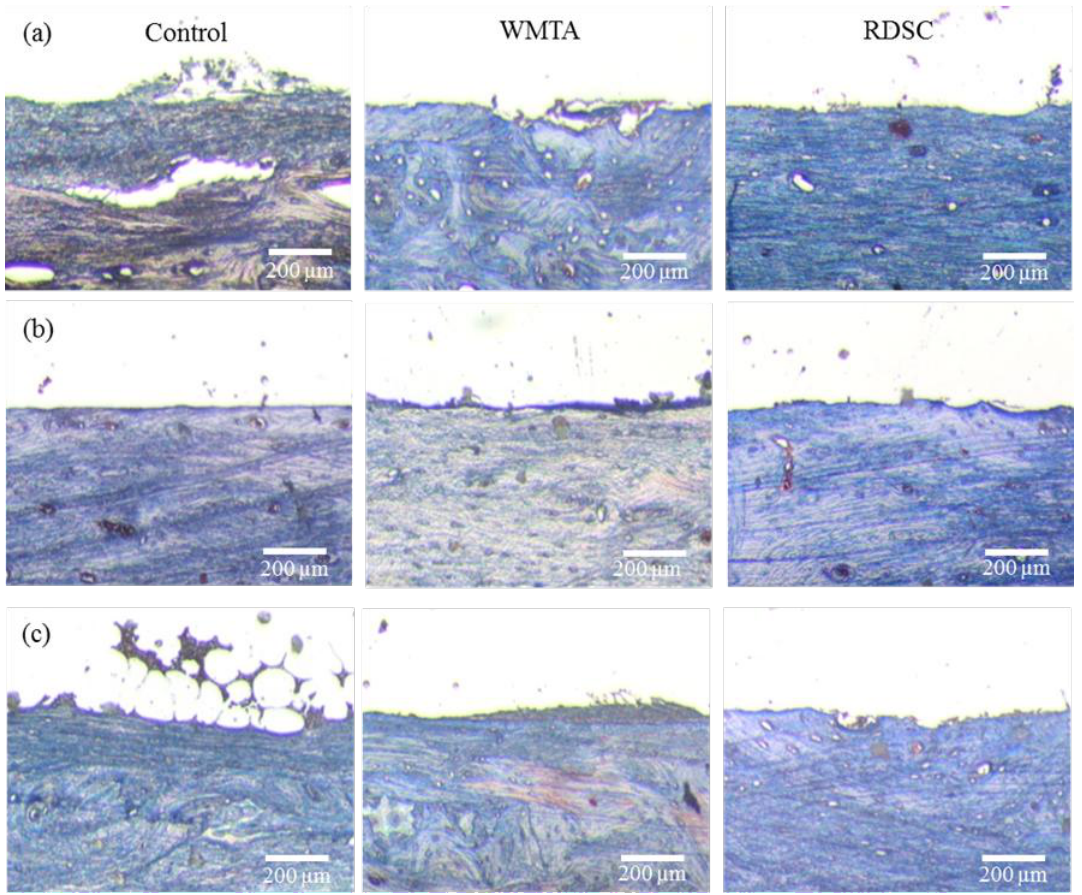
Figure 3. Modified Masson’s Trichrome staining photographs of rabbit femur surrounding the control, WMTA, and RDSC for different implantation time-points. ( a ) The 1-month WMTA and RDSC implant samples showed the deposition of collagen surrounding the implanted sites; ( b ) More staining was seen at the bony tissue adjacent to implant; ( c ) After six months implantation sites were surrounded by a connective tissue that was organized and dense with the presence of osteoblasts and osteoid matrix for all groups. (Original magnification